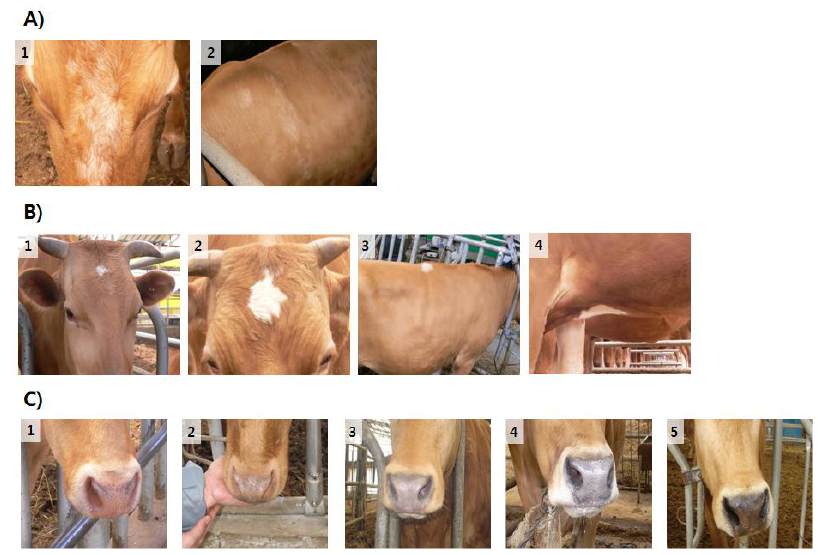
Figure 1. Hanwoo cattle with partial white or black coats mixed with brown (A), spotted white coat separated with brown (B), degree of nose pigmentation